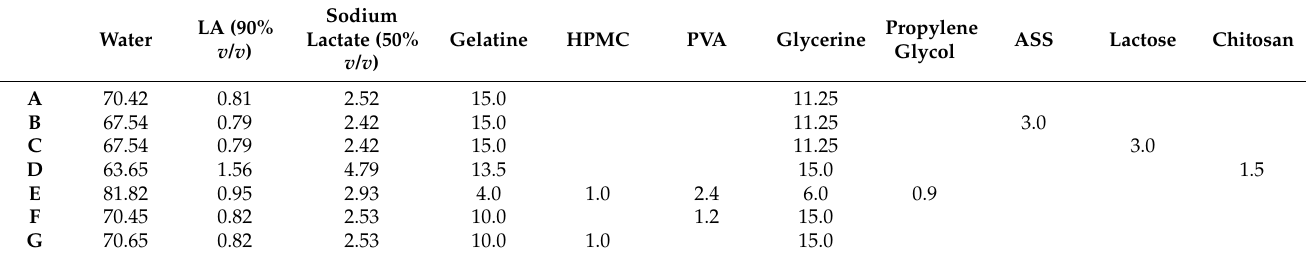
Table 6. Qualitative and quantitative composition (% w/w ) of gels used for vaginal sheets